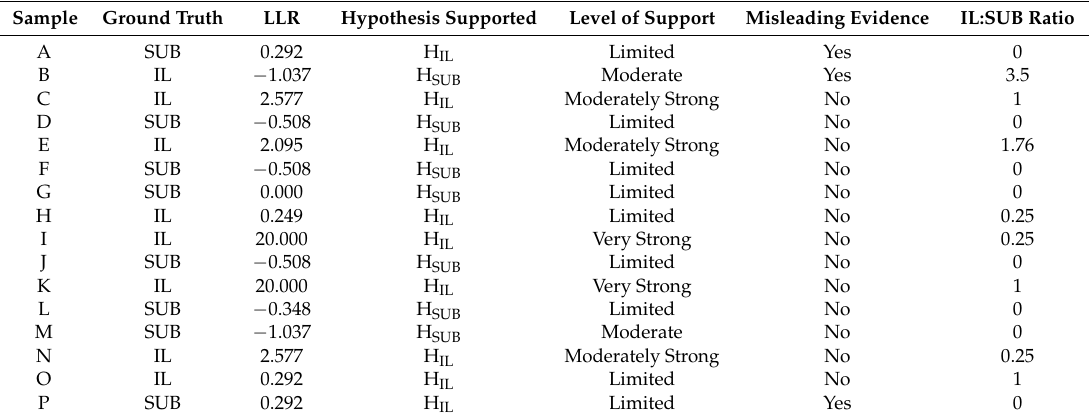
Table 5. Results from testing the QDA model from Distribution A, Table 1, on 16 known ground truth simulated casework